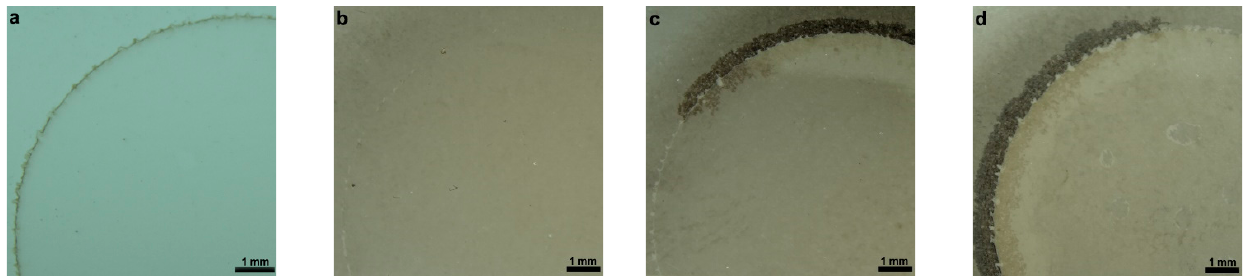
Figure 13. Surface morphology (detail) after the potentiodynamic tests of samples untreated ( a ), nitrided at 360 °C, 50 vol.% N 2 + 50 vol.% H 2 , for 1 ( b ) and 5 ( c ) h, and at 380 °C, 50 vol.% N 2 + 50 vol.% H 2 , for 3 h ( d ).